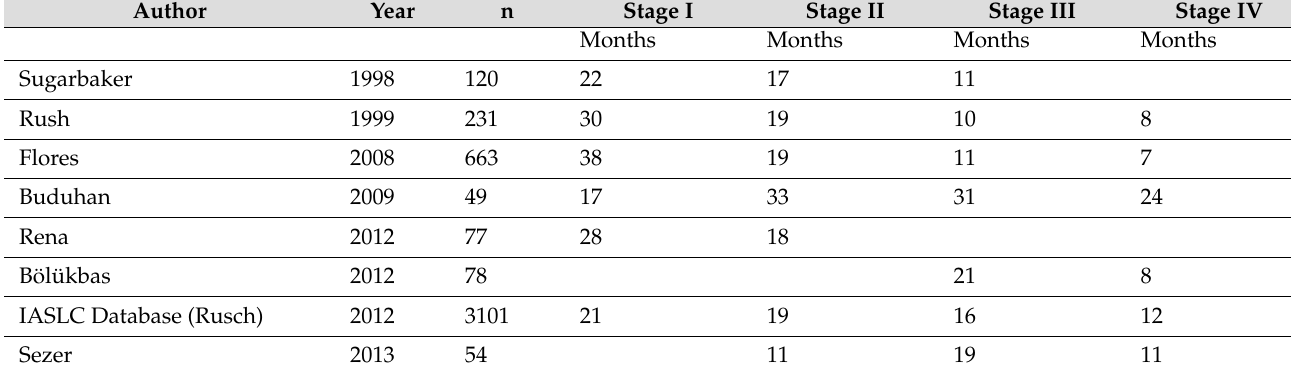
Table 8. Overview of median survival of MPM in the